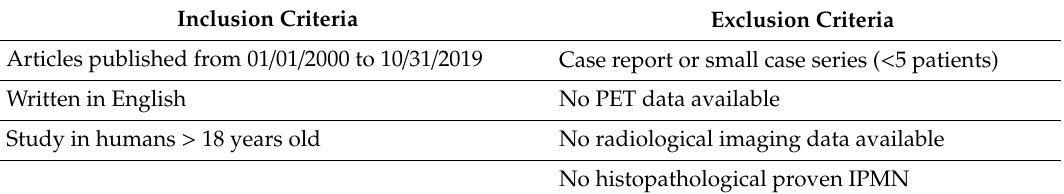
Table 1. Summary of inclusion and exclusion criteria adopted. PET: positron emission